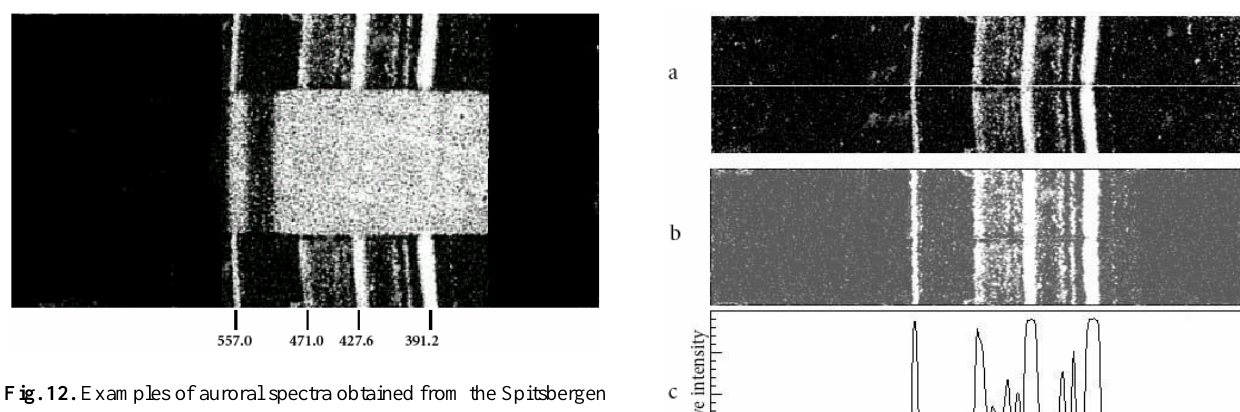
Fig. 12. Examples of auroral spectra obtained from the Spitsbergen Archipelago in 1899.